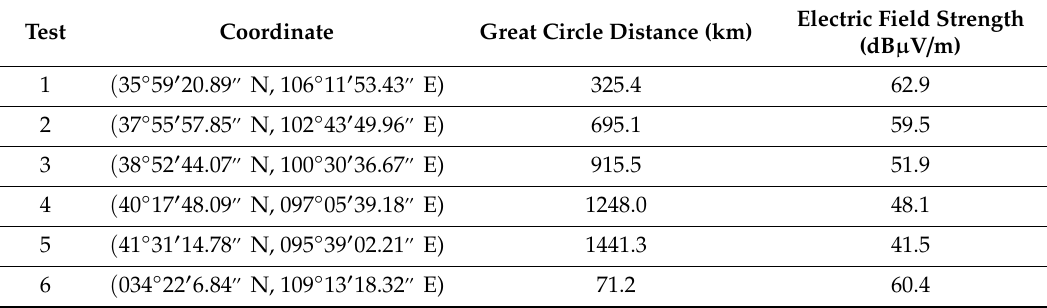
Table 2. Data for the six test sites.